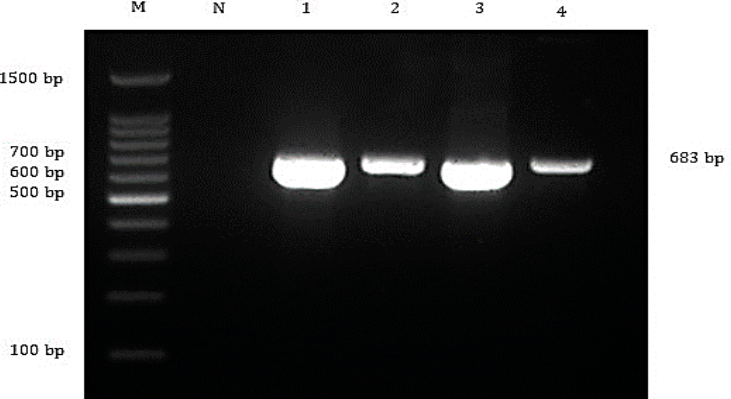
Figure 3. Agarose gel electrophoresis showing detection of 683 bp of Aeromonas hydrophila targeting 16S rRNA gene from the affected fish. Lane M = 1 kb DNA marker; Lane N = negative control; Lane 1 to 4 = All A. hydrophila -positive samples yielded 683 bp amplicons.